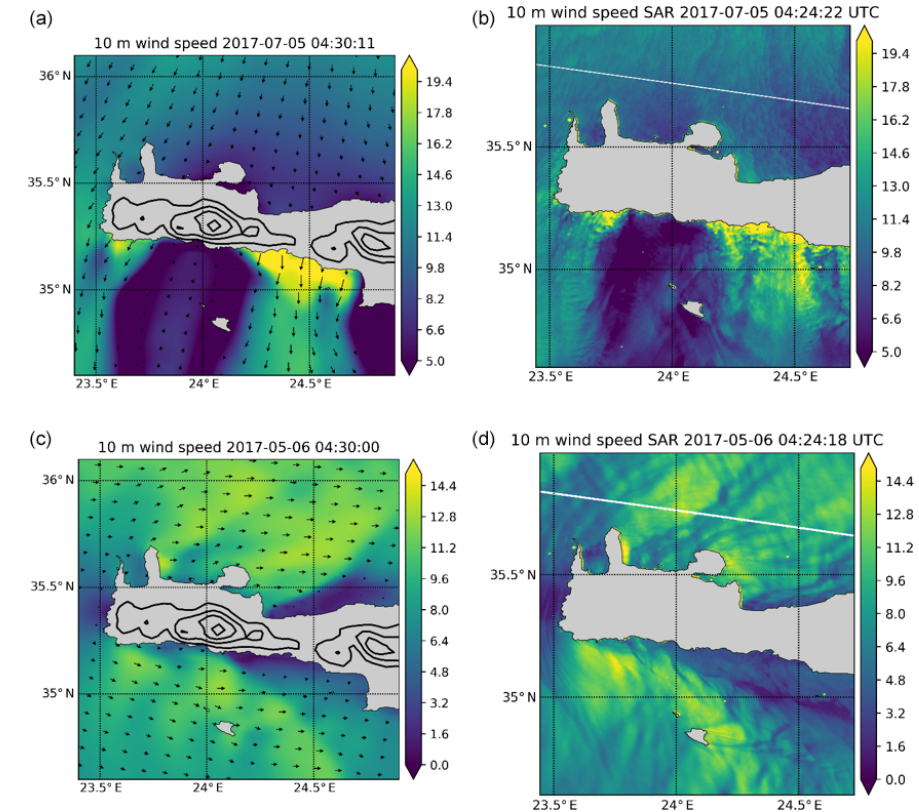
Figure 11. Wind speed (ms − 1 ) from WRF data (a, c) and SAR data (b, d) . (a, b) Northerly flow on 5 July 2017, 04:24UTC. (c, d) Westerly flow on 6 May 2017, 04:24UTC (the white lines in SAR panels are consecutive scene borders).